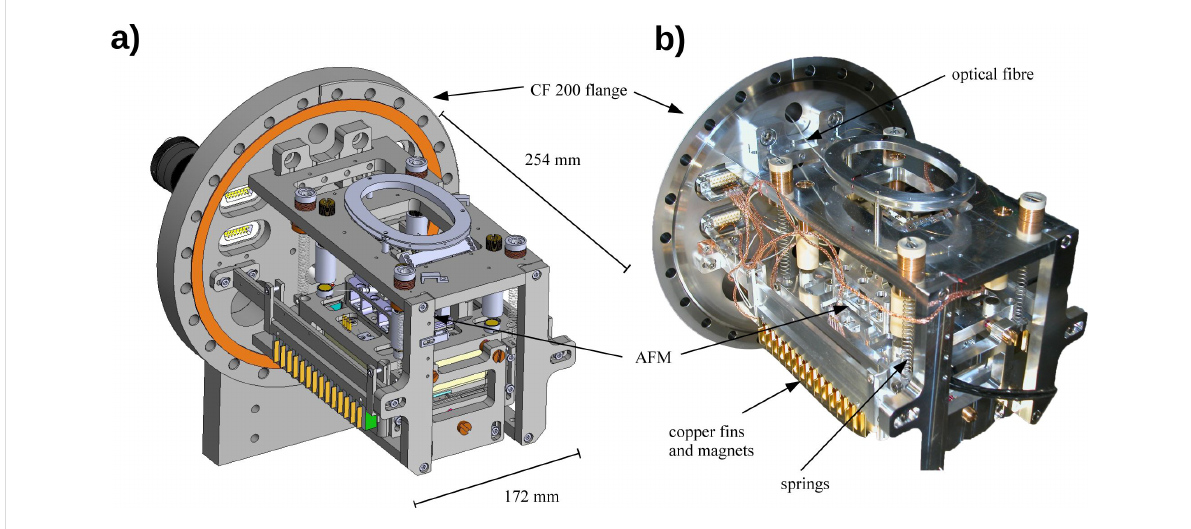
Figure 4: The atomic force microscope is assembled on a CF200 flange with four tension springs. Copper fins and magnets serve as an eddy current damping system to suppress vertical vibrations. In panel a, a CAD image is illustrated, whereas panel b shows a photography of the microscope.